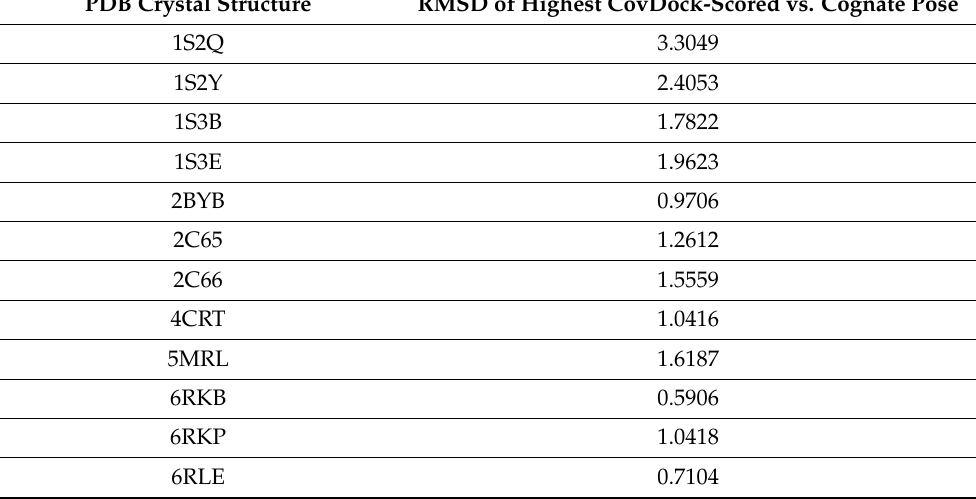
Table 2. hMAO-B covalent docking